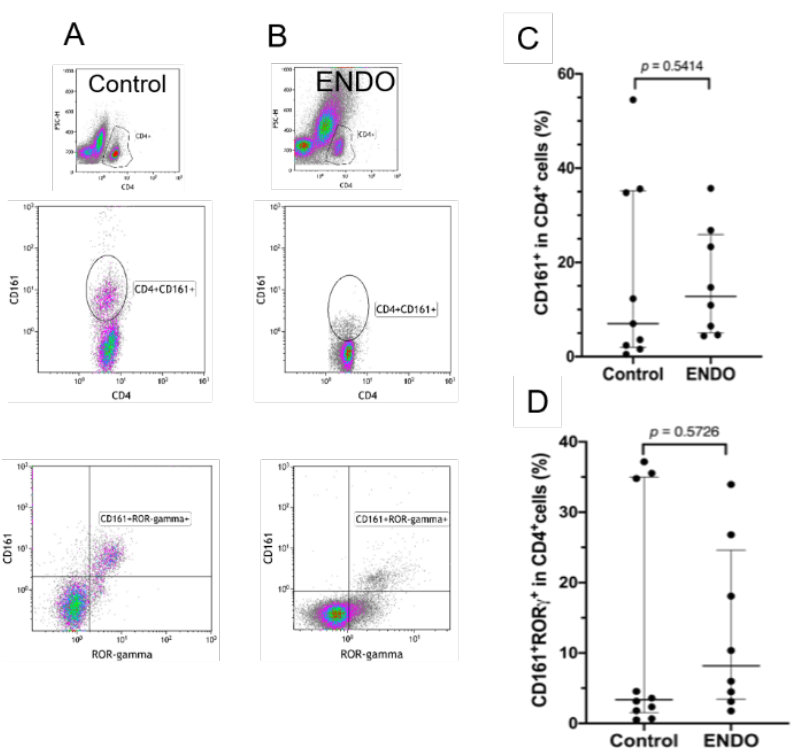
Figure 2. Flow cytometry gating strategy and analysis of the proportion of Th17 cells in the peritoneal fluid from control women (Control) and patients with endometriosis (ENDO). Figure includes a representative flow cytometry analysis showing identification of the respective T cell populations in both ( A ) control and ( B ) endometriosis groups. The analysis of the proportion of Th17 cells included evaluation of ( C ) CD161 + and ( D ) CD161 + ROR- γ + CD4 + T cell populations as described in the Materials and Methods section. The results are shown as median and interquartile range. Statistical differences between groups were tested by two-tailed Mann–Whitney U -test.